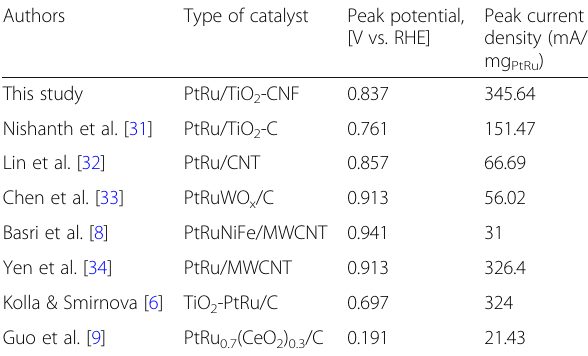
Table 5 Comparison of the performance results with the